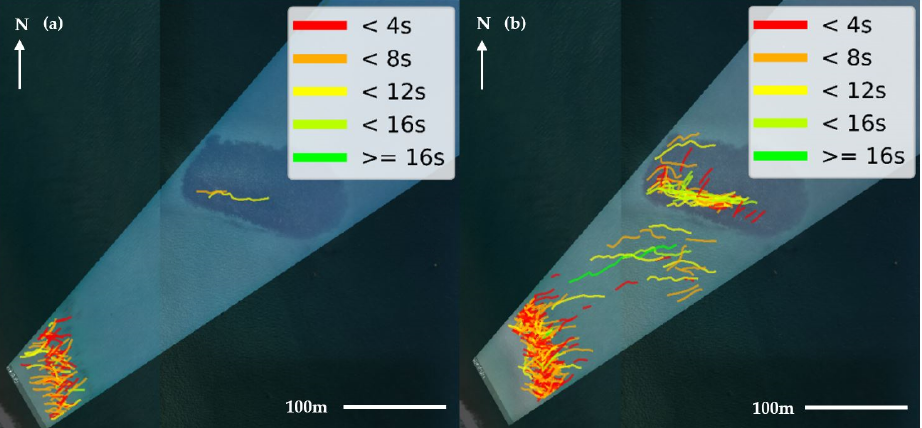
Remote Sens. 2021 , 13 , x FOR PEER REVIEW